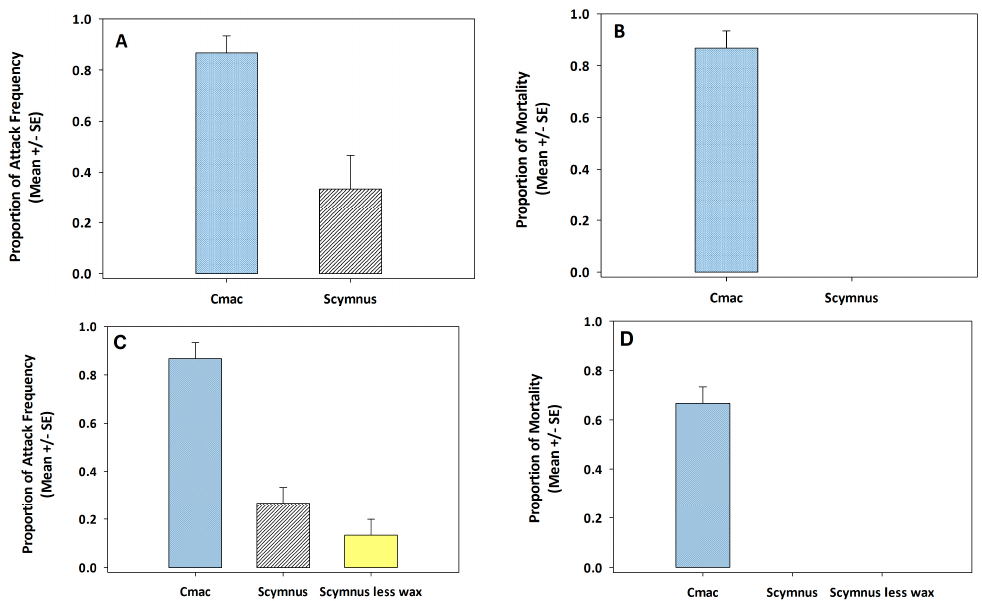
Figure 3. The mean ± SE proportional frequency of attack by S. invicta and mortality of C. maculata or Sc. creperus ( A , B ). The sample size was six observations for proportional attack frequency and proportional mortality estimates for C. maculata or Sc. creperus with or without S. invicta . The mean ± SE proportional frequency of attack by S. invicta and mortality of C. maculata , Sc. creperus , or non-wax covered Sc. creperus ( C , D ). The sample size was nine observations for proportional attack frequency, and mortality estimates for C. maculata , Sc. creperus , or non-wax-covered Sc. creperus with or without S. invicta .